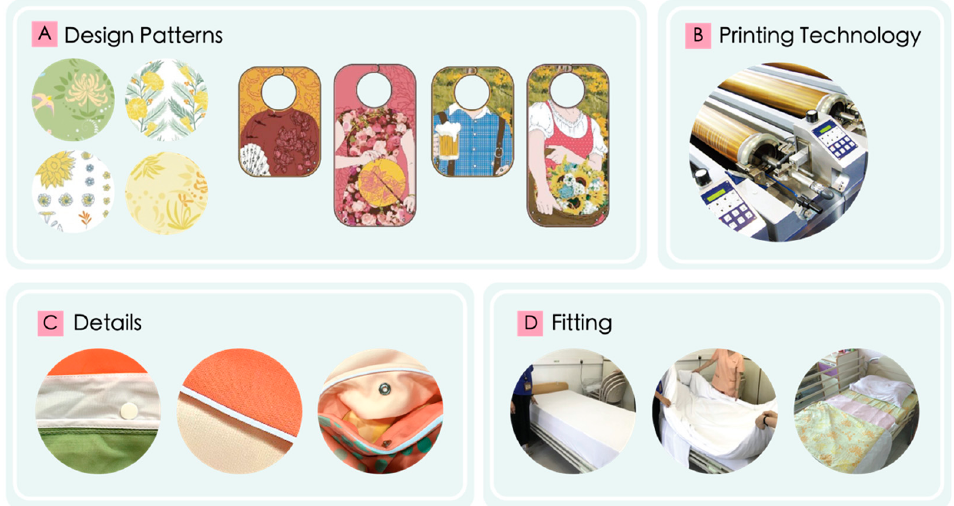
Figure 4. ( A ) The demonstration design of the handkerchief, bedding and apron; ( B ) cylinders for circular screen-printing; ( C ) detailed design elements; ( D ) fitting of bedding and the related design elements.